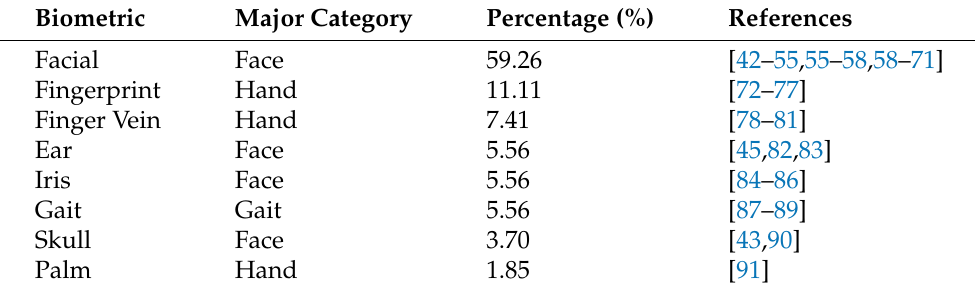
Table 1. Literature